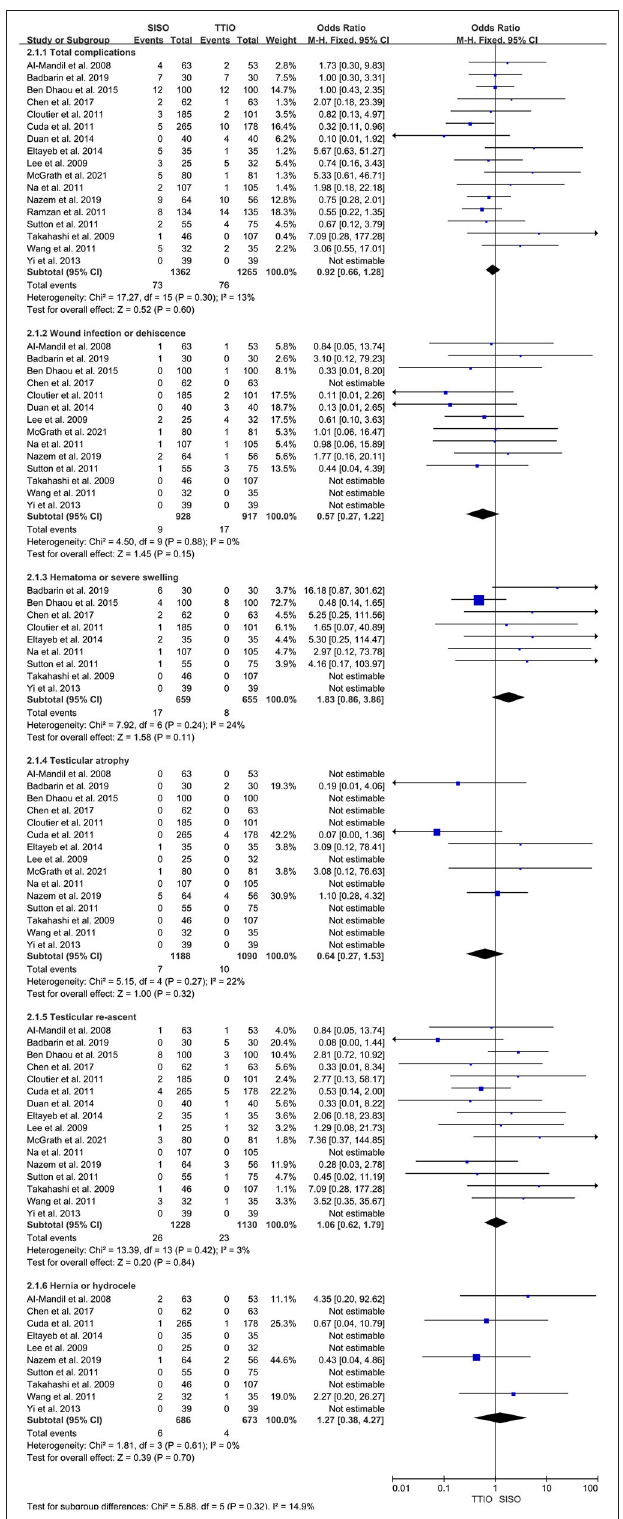
FIGURE 3 | Forest plot of total, short-term, and long-term complications between single-incision scrotal orchiopexy and traditional two-incision inguinal orchiopexy for primary palpable undescended